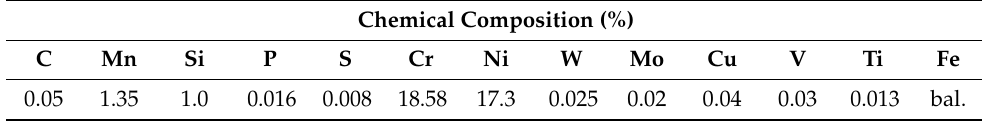
Table 1. Chemical composition of 304L austenitic stainless steel.